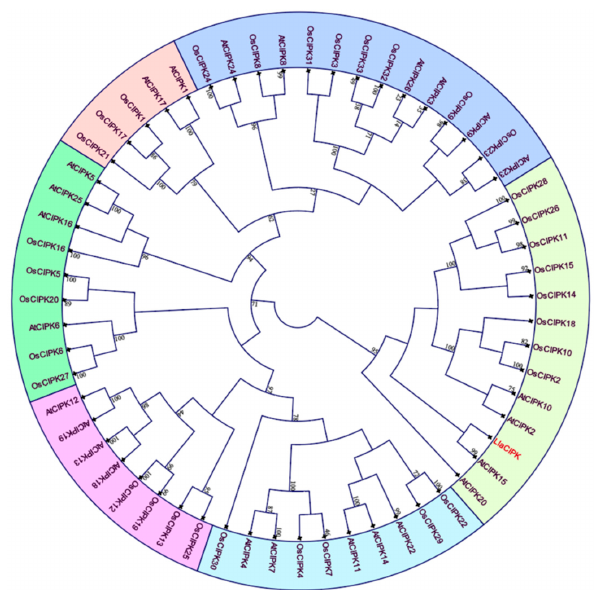
Figure 3. Phylogenetic tree depicting relationship among Lla CIPK (red color), Arabidopsis and rice. The different-colored arcs indicate different subgroups. Prefix ‘At’, and ‘Os’ indicate CIPK proteins from Arabidopsis and Oryza sativa respectively.